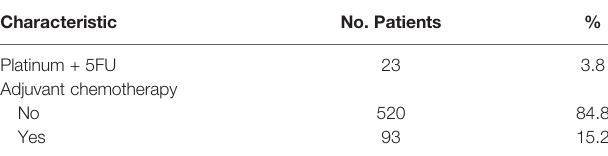
TABLE 1 | Clinical characteristics of patients and distribution of FIGO staging